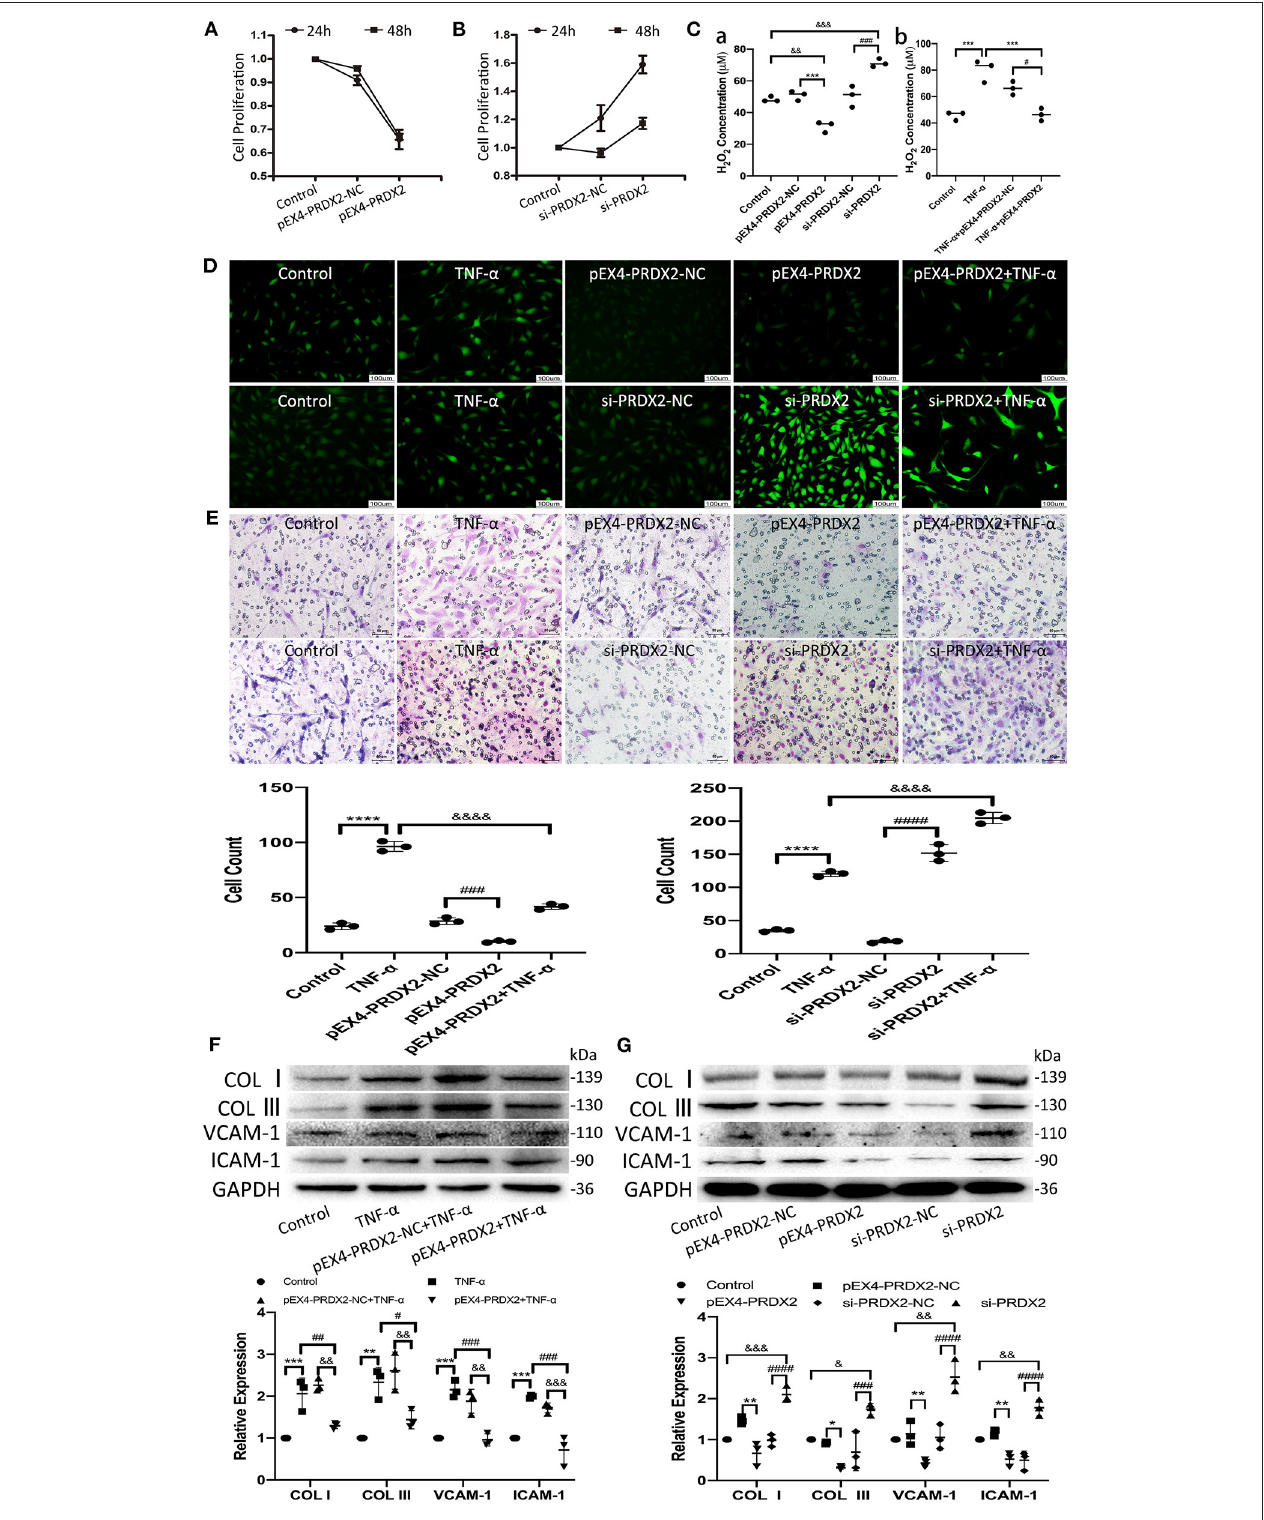
FIGURE 4 | PRDX2 attenuates ROS and potentially protects against the development of AS. (A,B) CCK-8 assay was applied to evaluate endogenously expressed PRDX2 on the proliferation of the CAVSMCs. (C) The H 2 O 2 concentration on pEX4-PRDX2 and si-PRDX2 transfection CAVSMCs and TNF- α treatment